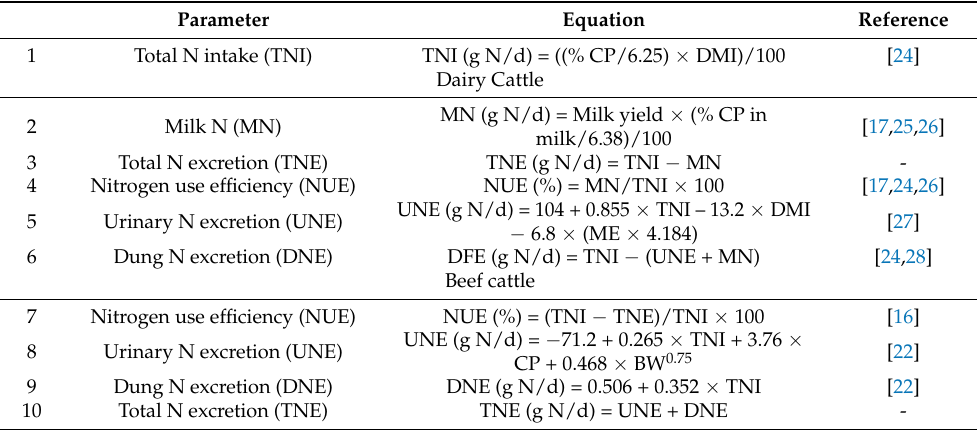
Table 1. Equations used to estimate nitrogen intake, nitrogen use efficiency and nitrogen excretion into urine and dung of Chilean